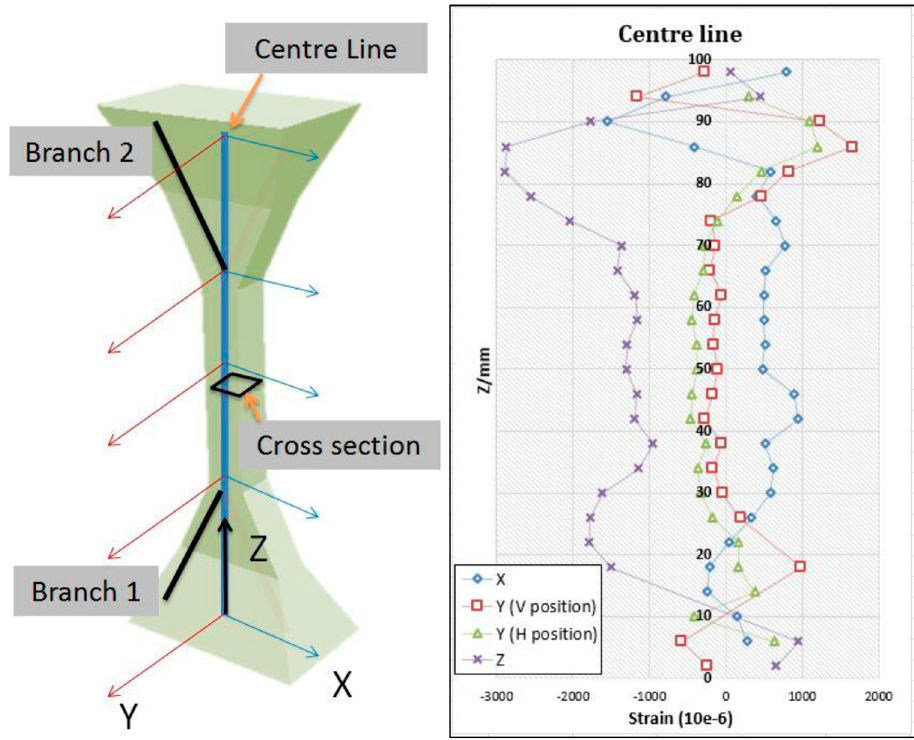
Figure 3. Neutron diffraction residual strains measured along the centre line of the sample.